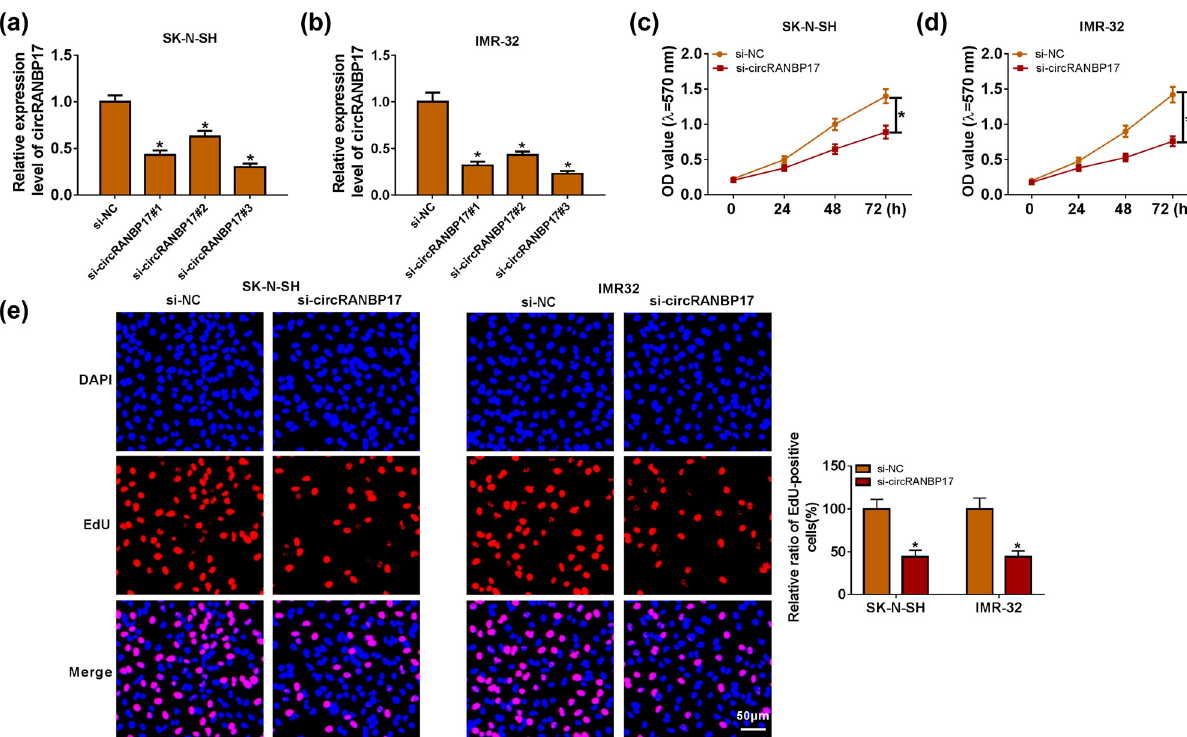
Figure 2: CircRANBP17 knockdown restrains cell proliferation in SK - N - SH and IMR - 32 cells. The knockdown e ffi ciency was detected by qRT - PCR in SK - N - SH ( a ) and IMR - 32 ( b ) cells. The cell proliferative capacity ( c – e ) in SK - N - SH and IMR - 32 cells transfected with si - circRANBP17 or si - NC were assessed by MTT and EdU assays. * P < 0.05.